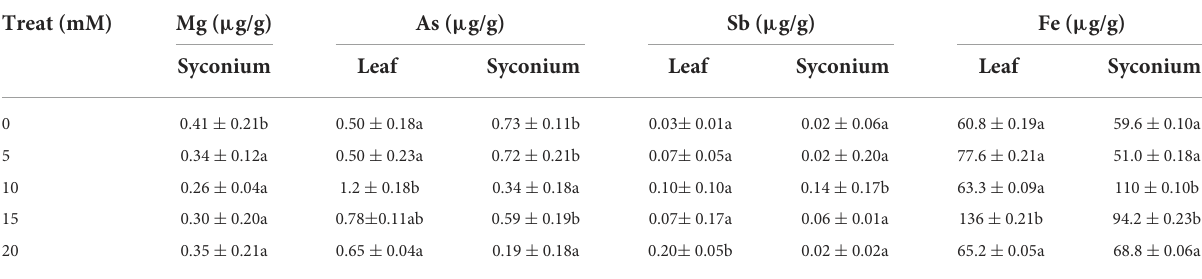
TABLE 5 The effects of H 2 O 2 on micro mineral uptake and accumulation of F. deltoidea plants under drought stressed conditions. Treat